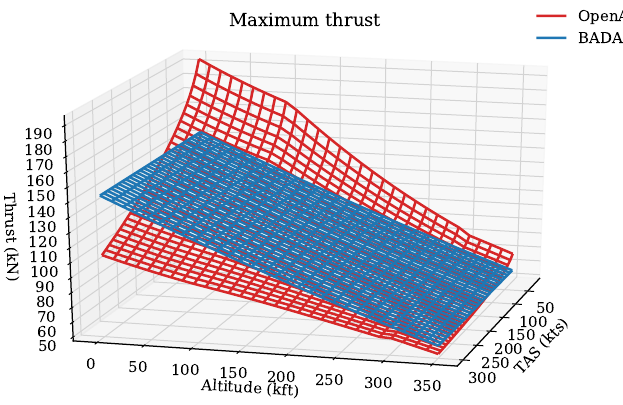
Figure 10. A320 maximum thrust (V2500-A1